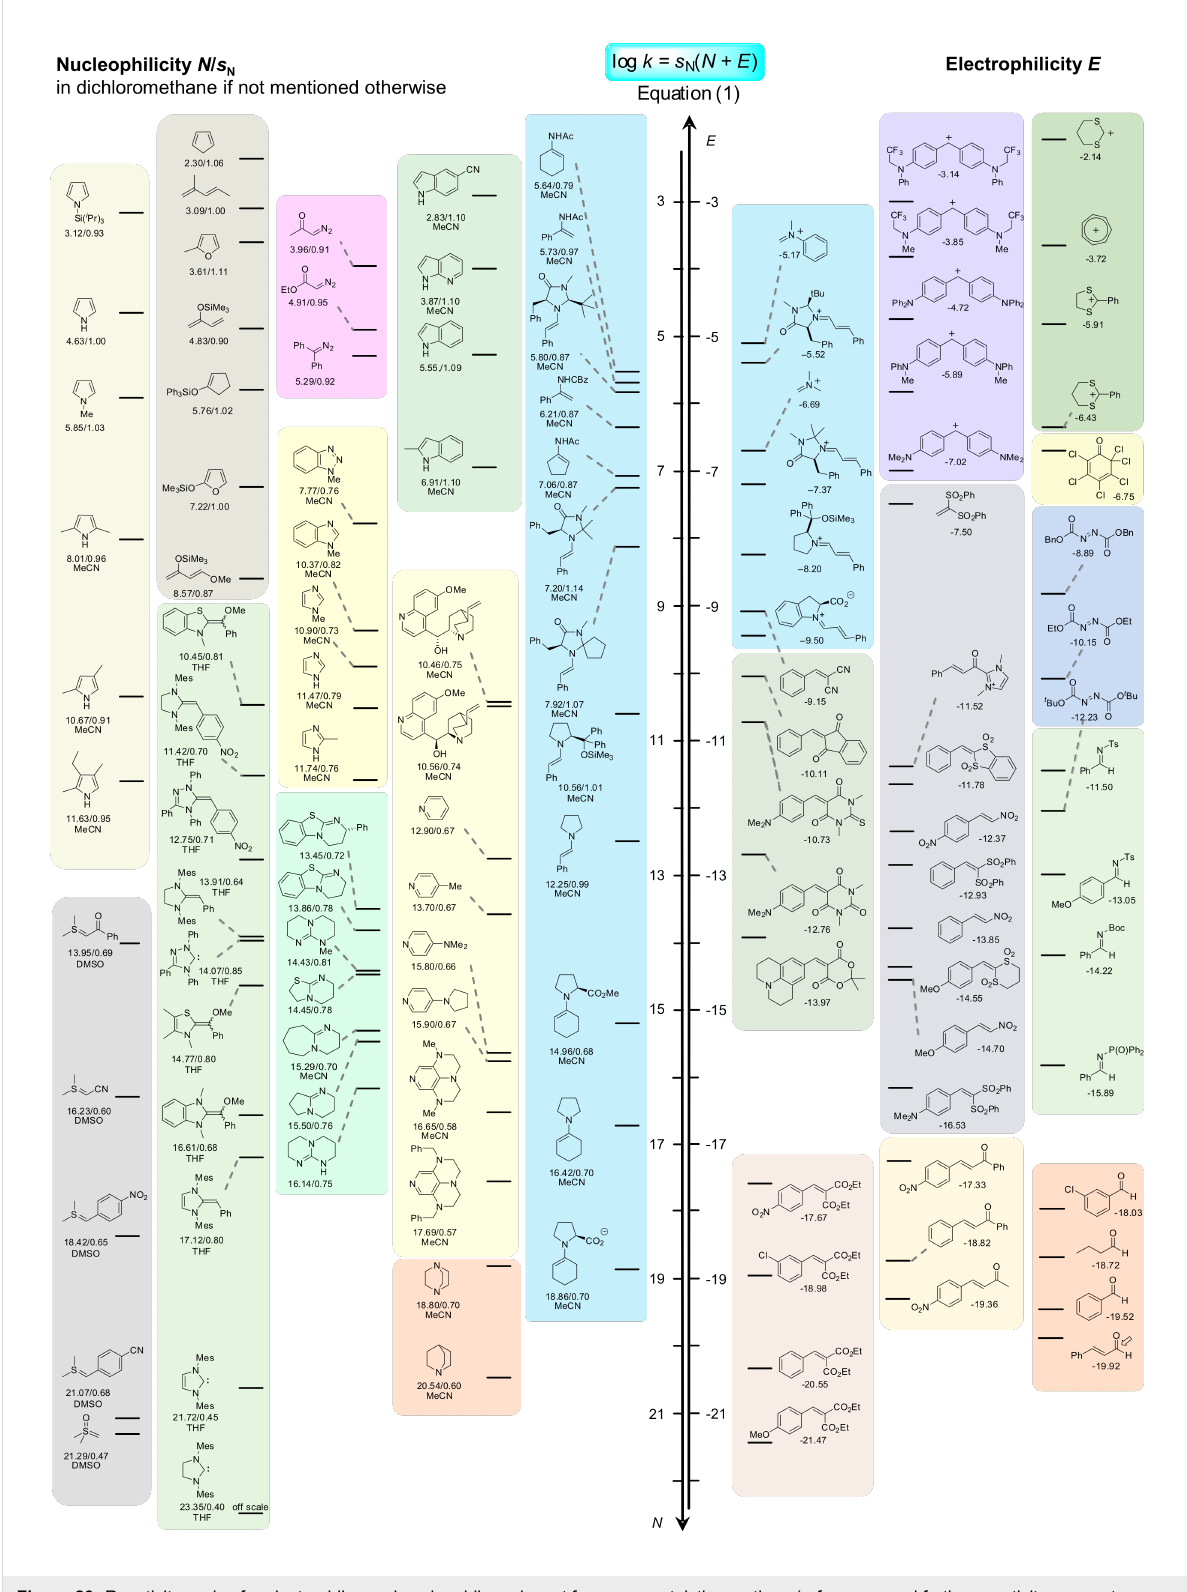
Figure 29: Reactivity scales for electrophiles and nucleophiles relevant for organocatalytic reactions (references and further reactivity parameters: